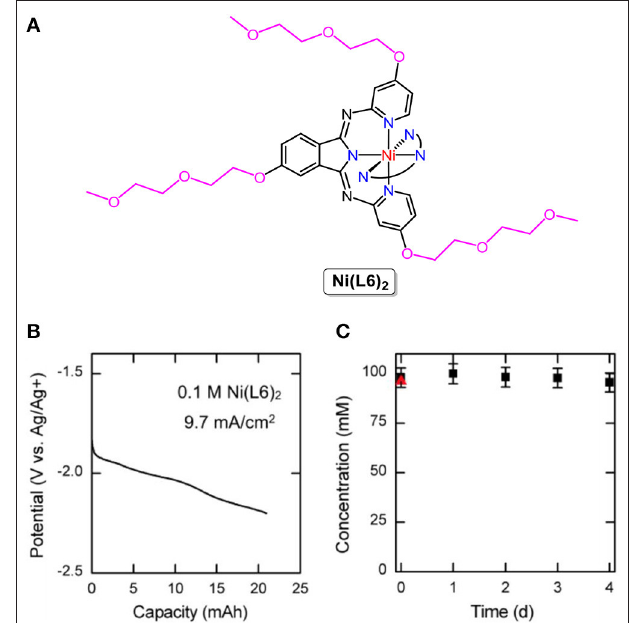
FIGURE 2 | (A) Molecular structure of Ni(L6) 2 . (B) Charging potential curve for a 2e reduction of a 100mM solution of Ni(L6) 2 . (C) Concentration of the charged Ni(L6) 2 as a function of time. The red triangle represents the concentration of the neutral solution before cycling. Reproduced with permission from Sevov et al. (2016). Copyright 2016, American Chemical